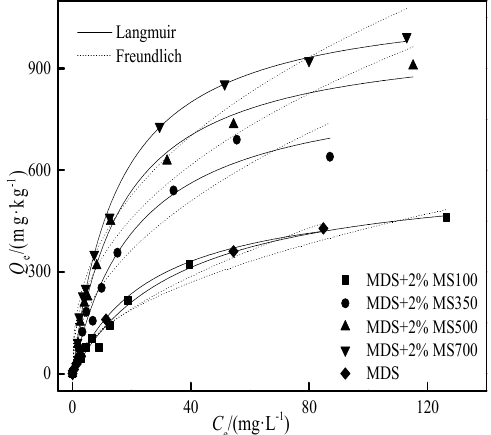
Figure 8. The effect of the biochar pyrolysis temperature on the Cd adsorption.